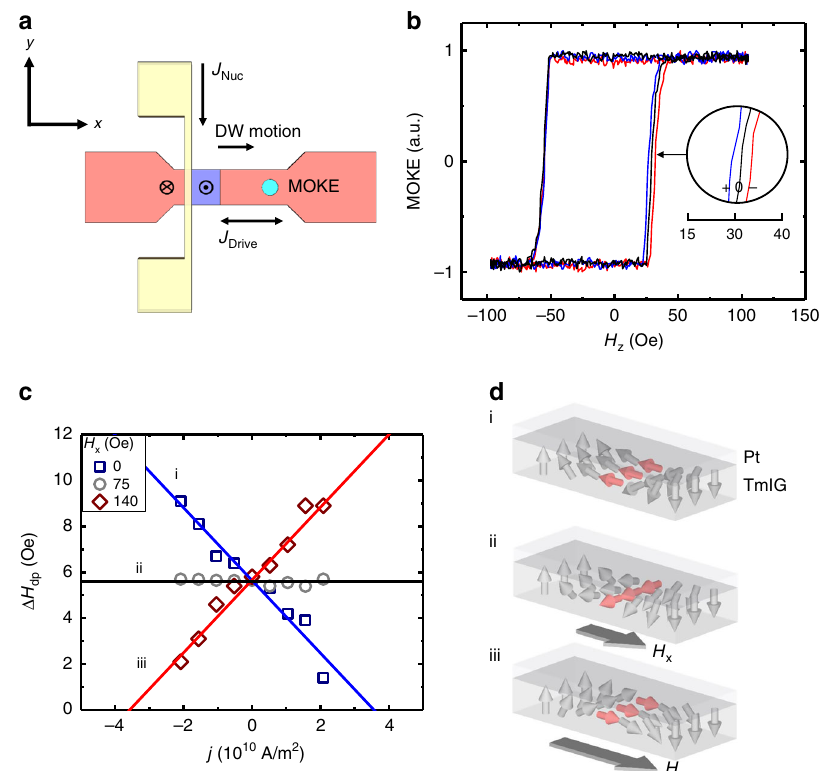
Fig. 2 Current-assisted domain wall motion in GGG/TmIG/Pt. a Schematic of the domain wall track with electrical connections. Red (blue) regions indicate down (up) net magnetization in the TmIG. Yellow regions represent the domain wall nucleation line. Magneto optical Kerr effect laser spot indicated by a turquoise circle. b Exemplary hysteresis loops of GGG/TmIG (6.0 nm)/Pt. Domain wall is nucleated on the positive zero crossing of the magnetic fi eld. Red (blue) loops depict the in fl uence of a positive (negative) current passed through the Pt overlayer. c Propagation fi eld ( Δ H dp ) as a function of d.c. current density ( J ) for various applied in-plane fi elds of an up-down domain wall. d Schematics illustrating the in fl uence of a longitudinal in- plane fi eld ( H x ) on a Néel domain wall. Arrow orientation and color indicates the net magnetization. Gray magnetic fi eld arrows indicate the strength of the in-plane fi eld. a.u., arbitrary